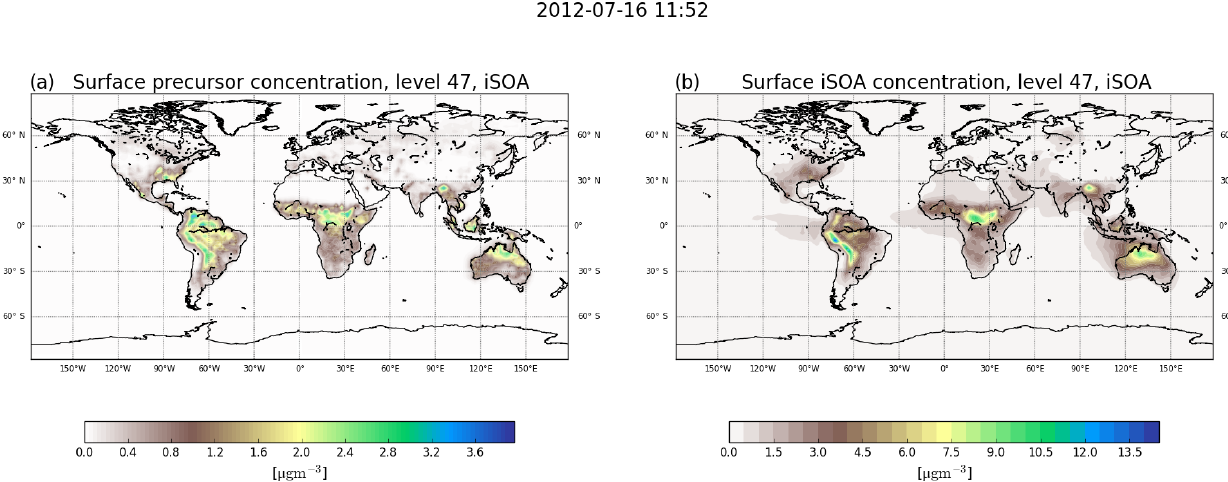
Figure 2. Global surface layer maps showing the iSOA precursor gas-phase concentration in (a) and the aerosol-phase iSOA concentration in (b) as annual averages for 2012 in µgm − 3 . The reader should note the different color scales; higher concentrations are reached in the aerosol phase ( b